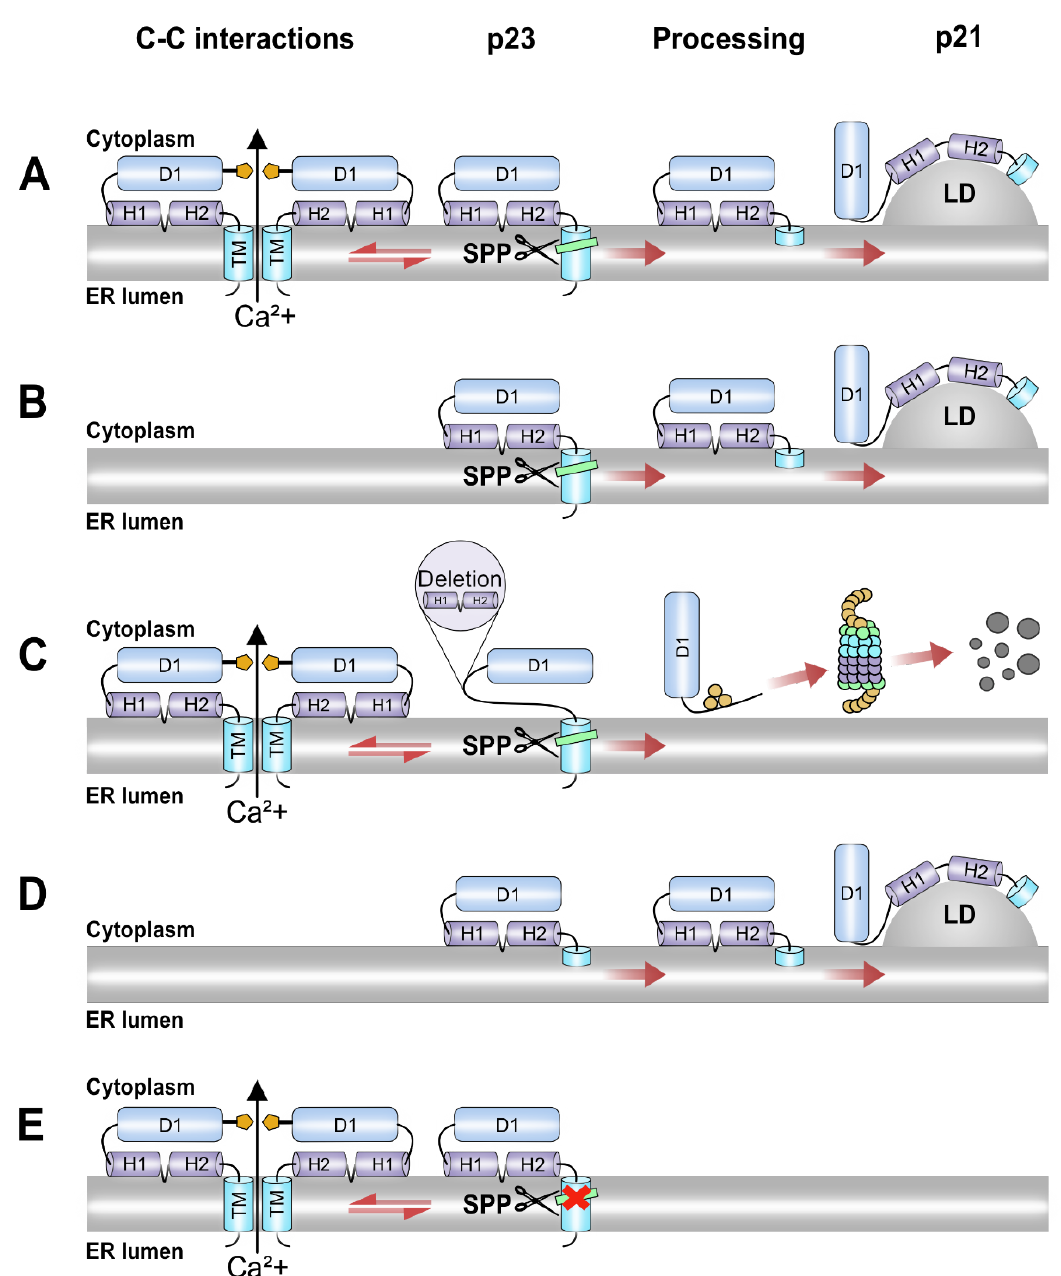
Figure 6. Model for activation of Ca 2+ signaling by HCV C. ( A ) The immature C (p23) protein with intact transmembrane (TM) domain (also known as D3) and capacity to self-associate into oligomeric structures at the ER membrane, enables Ca 2+ efflux from ER into the cytosol. After p23 is processed by SPP, the mature p21 protein is transported to the lipid droplets. ( B ) The immature p23 with intact TM domain, but defective in C-C interactions, does not perturb the ER membrane and hinders Ca 2+ efflux (e.g., ∆ 2–18, ∆ 61–68). The localization of the mature form (p21) to lipid droplets is retained. ( C ) The immature form p23 with deletions in domain 2 (e.g., ∆ 124–142, ∆ 147–161) allows membrane perturbation prior to processing, but is rapidly degraded after maturation by SPP. ( D ) The C proteins with truncated TM domain (e.g., 1–173) do not allow Ca 2+ efflux but are transported into lipid droplets. ( E ) The intermediate p23 deficient in SPP cleavage (e.g., spmt, ∆ 81–123) is retained in the ER membrane and is hyperactive for Ca 2+